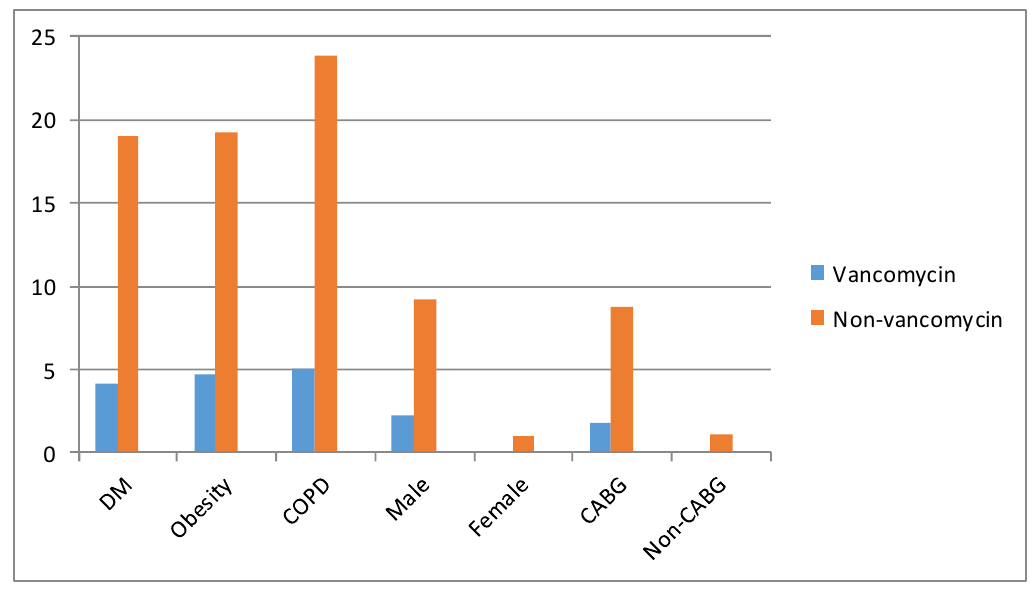
Chart 1 : Percentage wise distribution of DSWI in vancomycin and non vancomycin group in different risk factor